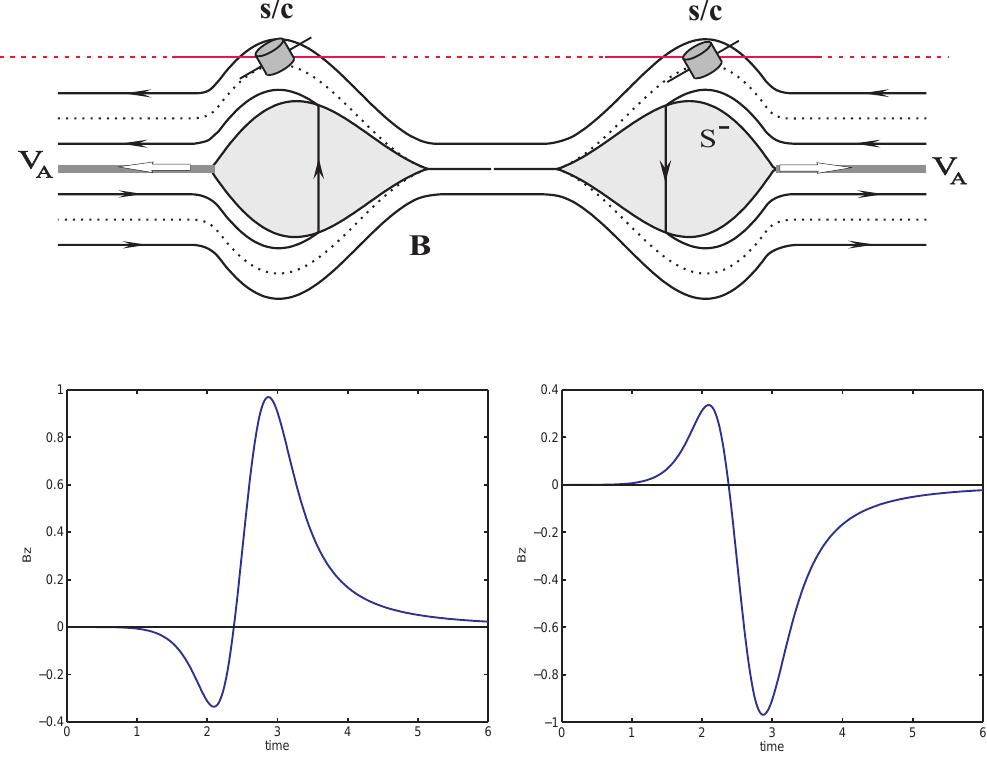
Fig. 1. Disturbances in B z measured by spacecraft on opposite sides of the reconnection line. The leftwards positioned spacecraft measures first negative and then positive B z disturbances, when the plasma outflow region passes by. For the rightward positioned spacecraft the situation is vice versa. The field line configuration corresponds to those of the Earth’s